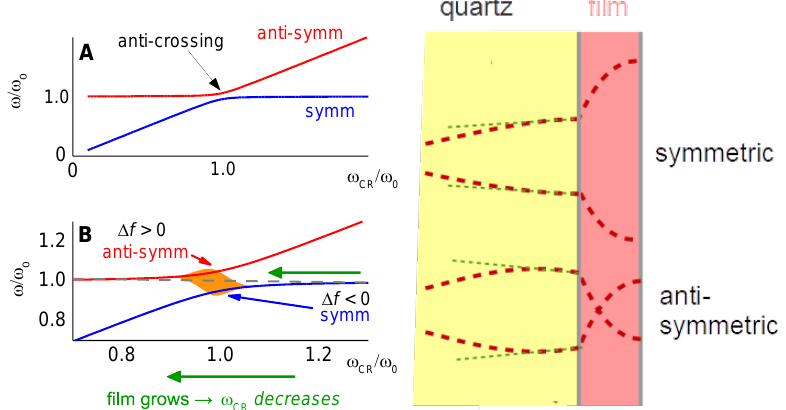
Figure 19. If the small-load approximation is abandoned, a film resonance produces two separate peaks in the conductance trace, G el ( ω ) , corresponding to two separate modes of vibration. The shear gradients inside the film have opposite sign for the two modes, hence the labels “symmetric” and “antisymmetric”. Far away from the coupling condition, ω 0 and ω CR are not affected by coupling (to the right and to the left in panel ( A )). If the two frequencies match and if the two modes indeed couple, anticrossing results. For a more quantitative treatment see Chapter 4.63 in [5]. Panel ( B ) shows an enlargement of panel ( A ) in the region of anti-crossing. If the bandwidth is large, the two modes are not actually resolved (sketched in orange in panel ( B )). When the film becomes thicker, ∆ f is less than zero, following Sauerbrey. Because the two modes are not resolved at the coupling condition, the peak in G el ( ω ) is broad. The center of the peak gradually moves up, because the antisymmetric mode becomes stronger. Eventually, the peak sharpens again and returns to the original frequency from above. A similar behavior is seen in Figure 16, based on Equation